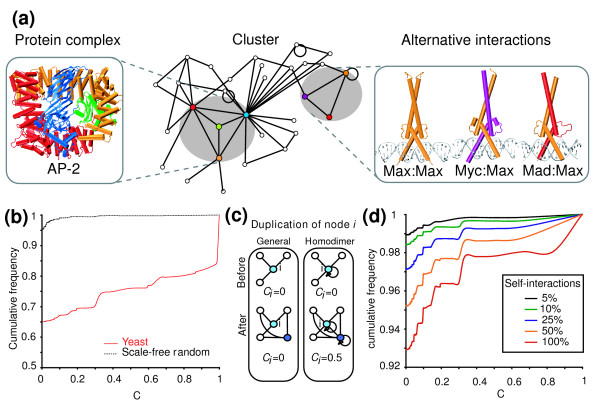
Clusters in PINs. (a) A small section of a PIN in S. cerevisiae is represented as a graph where nodes correspond to proteins and edges to physical interactions between pairs of proteins. One definition of a module in this work is a highly connected subgraph, such as that shaded in the figure (left), in which the central (green) node has a maximum clustering coefficient (C = 1). A clustering coefficient can be calculated for each protein in the network and measures the number of interactions between neighbors of that protein, divided by the total number of possible interactions between those neighbors. In this example, the green node and its fully connected neighborhood correspond to the protein complex AP-2 [49]. Fully connected subgraphs can also represent interactions that are dissociated in time and/or in space. For example, the shaded cluster on the right represents members of the basic helix-loop-helix transcriptional regulator family, in which duplication of a homodimeric protein with inheritance of interactions resulted in Max existing as a homodimer, as well as distinct dimers of paralogous proteins (c-Myc and Mad1) [34,35]. (b) Cumulative frequency distribution of the clustering coefficients in the Yeast PIN and in randomized networks with exactly the same degree distribution (scale-free random; see the Randomization by link shuffling section in Materials and methods for details). This shows that high clustering of real PINs, and thus their modularity, is a characteristic of their biology and not of the degree distribution. (c) Cartoon illustrating the consequences of duplication with conservation of interactions for the clustering coefficient of node (protein) i (Ci). In each case the network is shown before and after duplication of a protein that either interacts with itself or does not. The bottom part of the cartoon summarizes the effect on the clustering coefficient of the protein. (d) Cumulative frequency distribution of clustering coefficients in the simulated networks, with varying proportions of self-interactors at the start of the simulation. The fraction of proteins with higher clustering coefficients increases with the proportion of self-interactors.